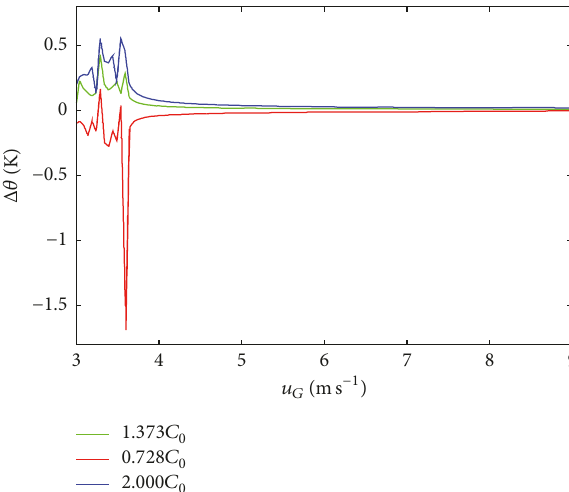
Figure 2: Mean temperature at 5 m, for different CO 2 concentration (indicated in the legend), as a function of the geostrophic wind.